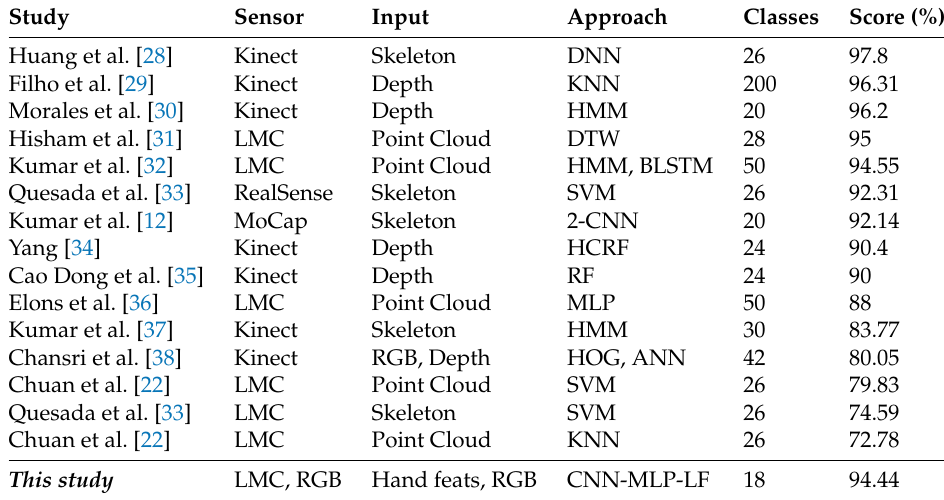
Table 1. Other state-of-the-art works in autonomous Sign Language Recognition, indirectly compared due to operation on different datasets and with different sensors. Note: It was observed in this study that classification of unseen data is often lower than results found during training, but many works do not benchmark this